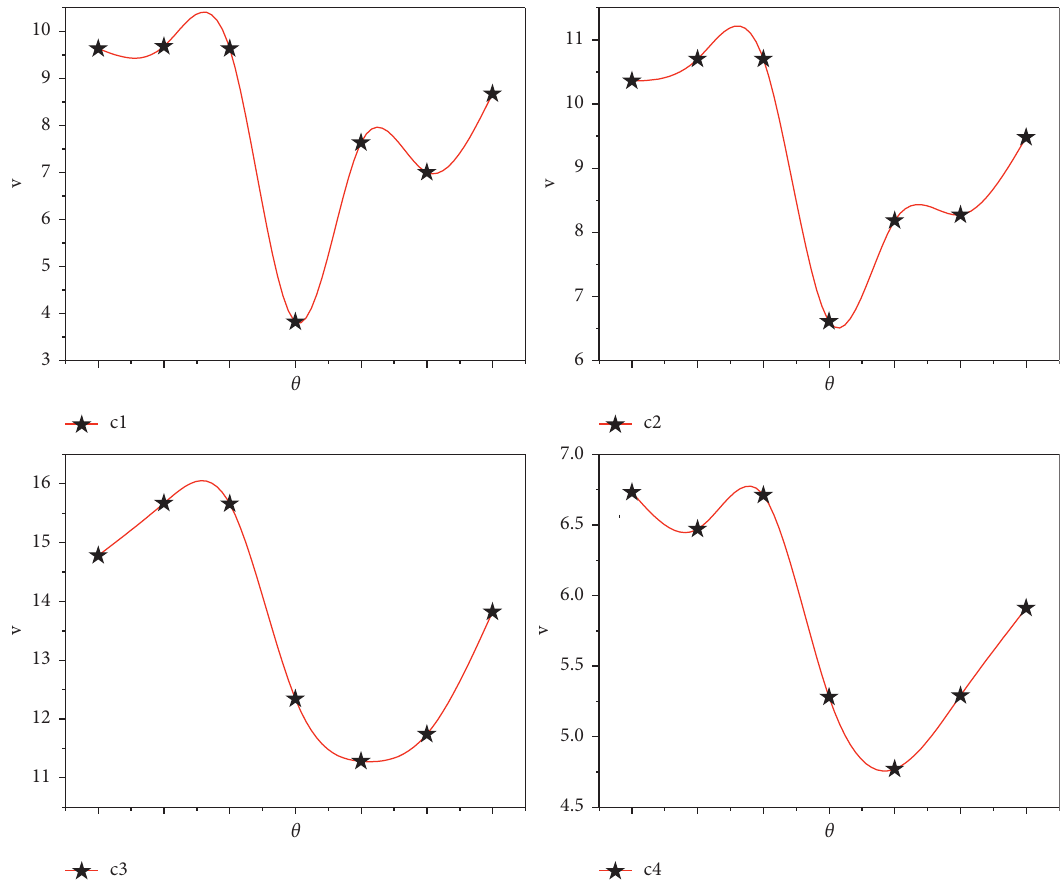
Figure 2: Bifurcation curves mapped on the parameter plane ( θ , v ) for fixed parameters a – c � 8.73, b � 1.87 and u �